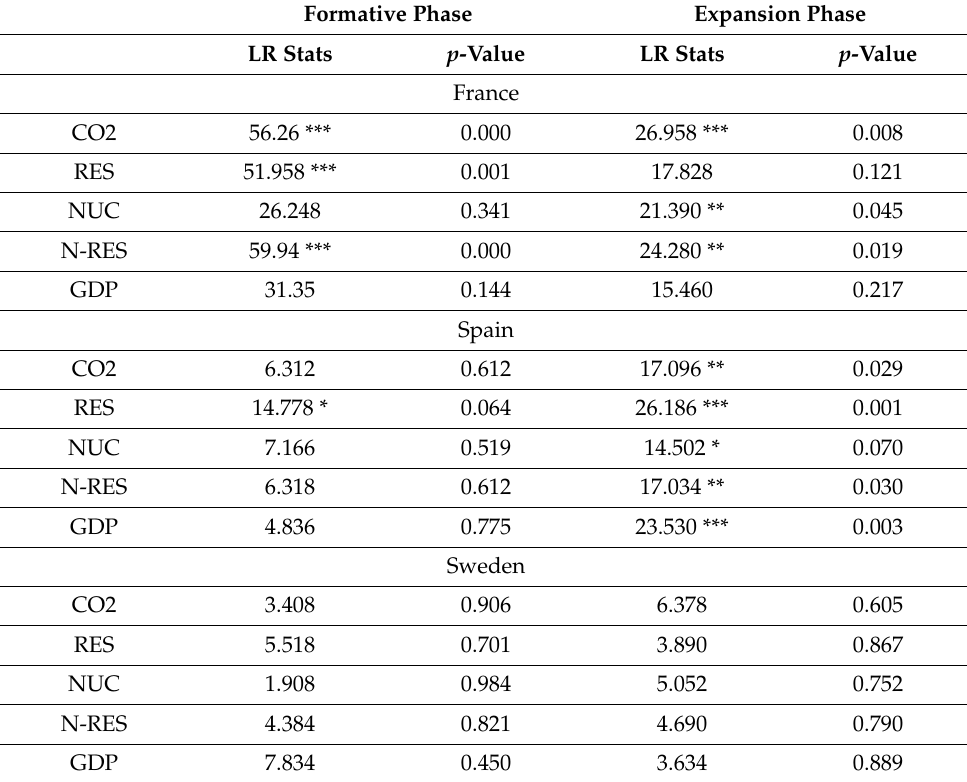
Table A5. Likelihood Ratio (LR) test